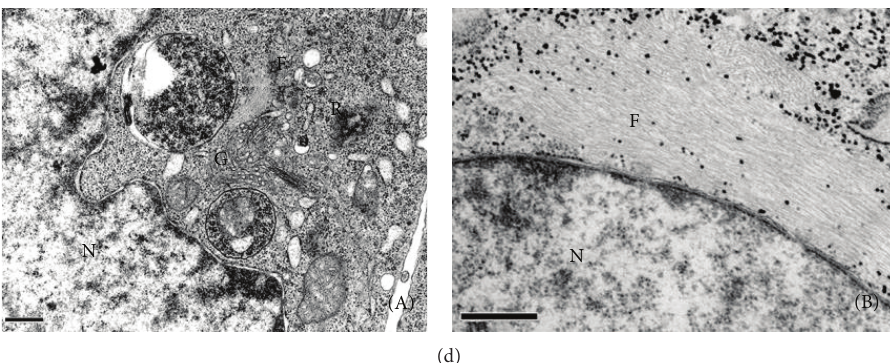
Figure 3: Characterization of eMSCs and BMSCs. (a) Growth curves of eMSCs and BMSCs. (b) Representative histograms of the cell surface marker expression on eMSCs (p6) and BMSCs (p3) analysed by flow cytometry, the labelled cells represented by the green line populations (M1),andrelevantisotype-matchedcellsdepictedbytheblueline(M2). (c)Immunofluorescentstainingformesodermandstemnessmarkers. Antibody staining (green or red) with DAPI nuclear staining (blue) (bars = 50 𝜇 m). (d) Transmission electron microscopy of eMSCs (p6). (A), (B): eMSCs bars = 0.5 𝜇 m, “N”: nucleus of cell; “M”: mitochondrion; “F”: filaments fibres; “G”: Golgi apparatus; “R”: rough endoplasmic